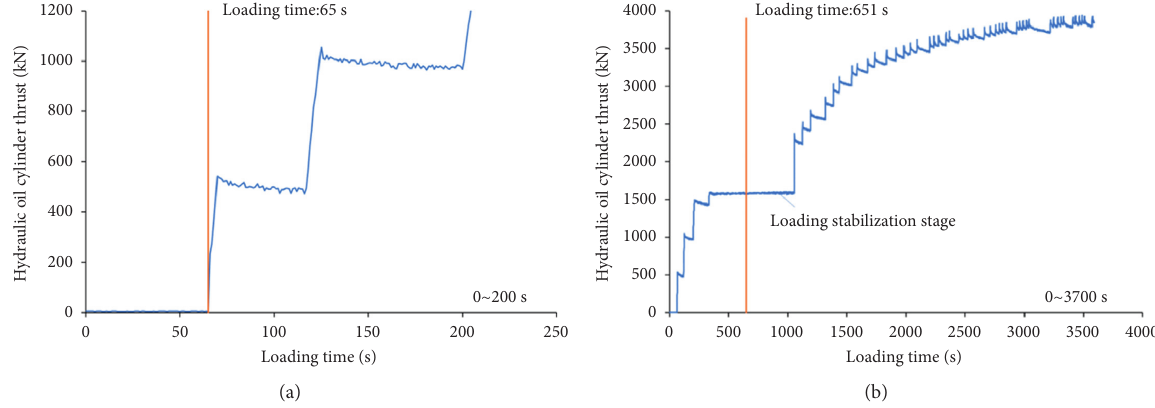
Figure 8: Variation in hydraulic oil cylinder thrust with time: (a) 0 ∼ 200 s; (b) 0 ∼ 3700